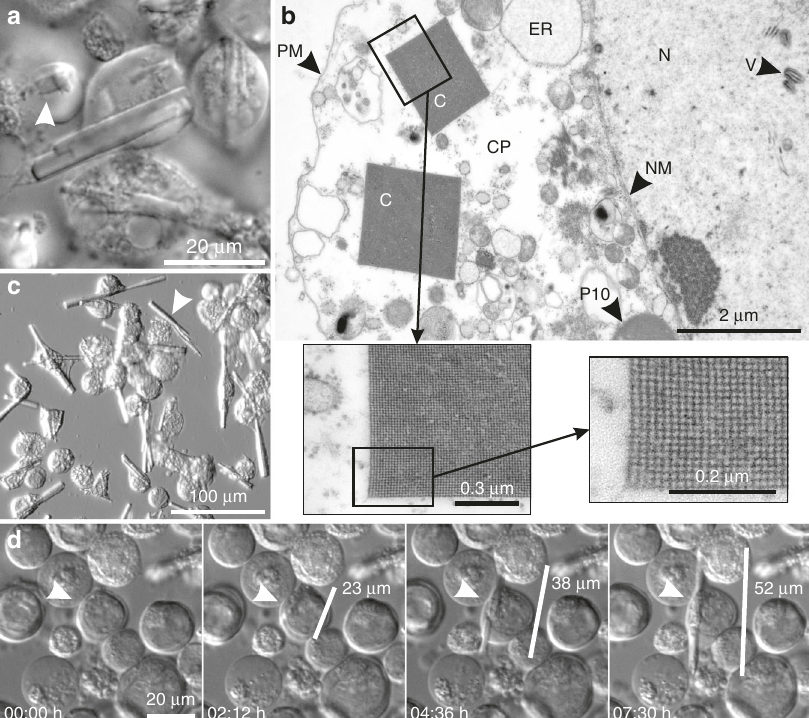
Fig. 1 Morphology and growth of TbIMPDH crystals in living insect cells. a Differential interference contrast (DIC) image of Sf9 cells 6 days p. i. with recombinant baculovirus containing the gene for TbIMPDH. Needle-shaped crystals, mostly extending the cell-body, are clearly visible. The arrowhead points to a vertical crystal, indicating the rectangular shape of the needles. b Transmission electron micrograph of a cross section of two TbIMPDH crystals within the cytoplasm of a Sf9 cell 6 days p. i. showing a clear crystal lattice with large water channels. C TbIMPDH crystal, CP cytoplasm, ER endoplasmic reticulum, N nucleus, NM nuclear membrane, P10 baculoviral P10 protein aggregate, PM plasma membrane, VP - viral particles. c Modulation contrast image of Sf9 cells showing multiple TbIMPDH crystals 7 days p. i., located within living cells and free in the surrounding medium (arrowhead). d Growth of a TbIMPDH crystal at 5 days p. i. in Sf9 cells taking place over the course of several hours. The crystal grows simultaneously in two dimensions. See also Supplementary Movie